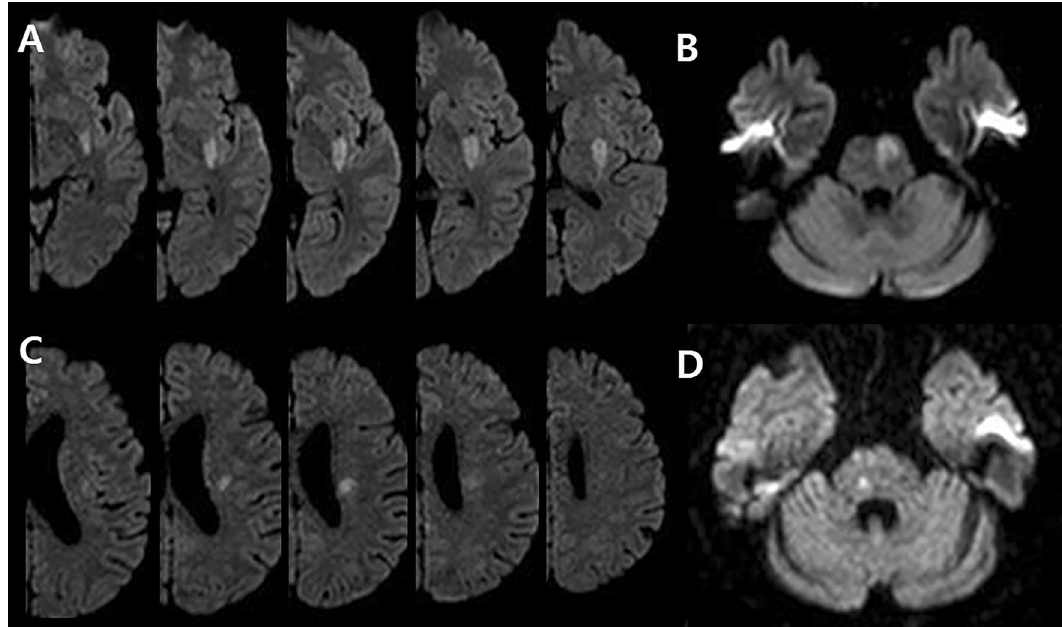
Figure 2. Representative examples of distal and proximal single subcortical infarction in the anterior and posterior circulation. SSI single subcortical infarction. ( A ) Anterior proximal SSI, ( B ) posterior proximal SSI, ( C ) anterior distal SSI, and ( D ) posterior distal